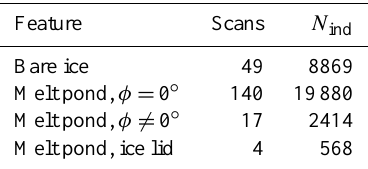
Table 2. Scatterometer scans of discrete features collected between 16 and 24 June 2012 on level first-year sea ice at the Arctic-ICE study site, including total number of independent samples ( N ind ) for each